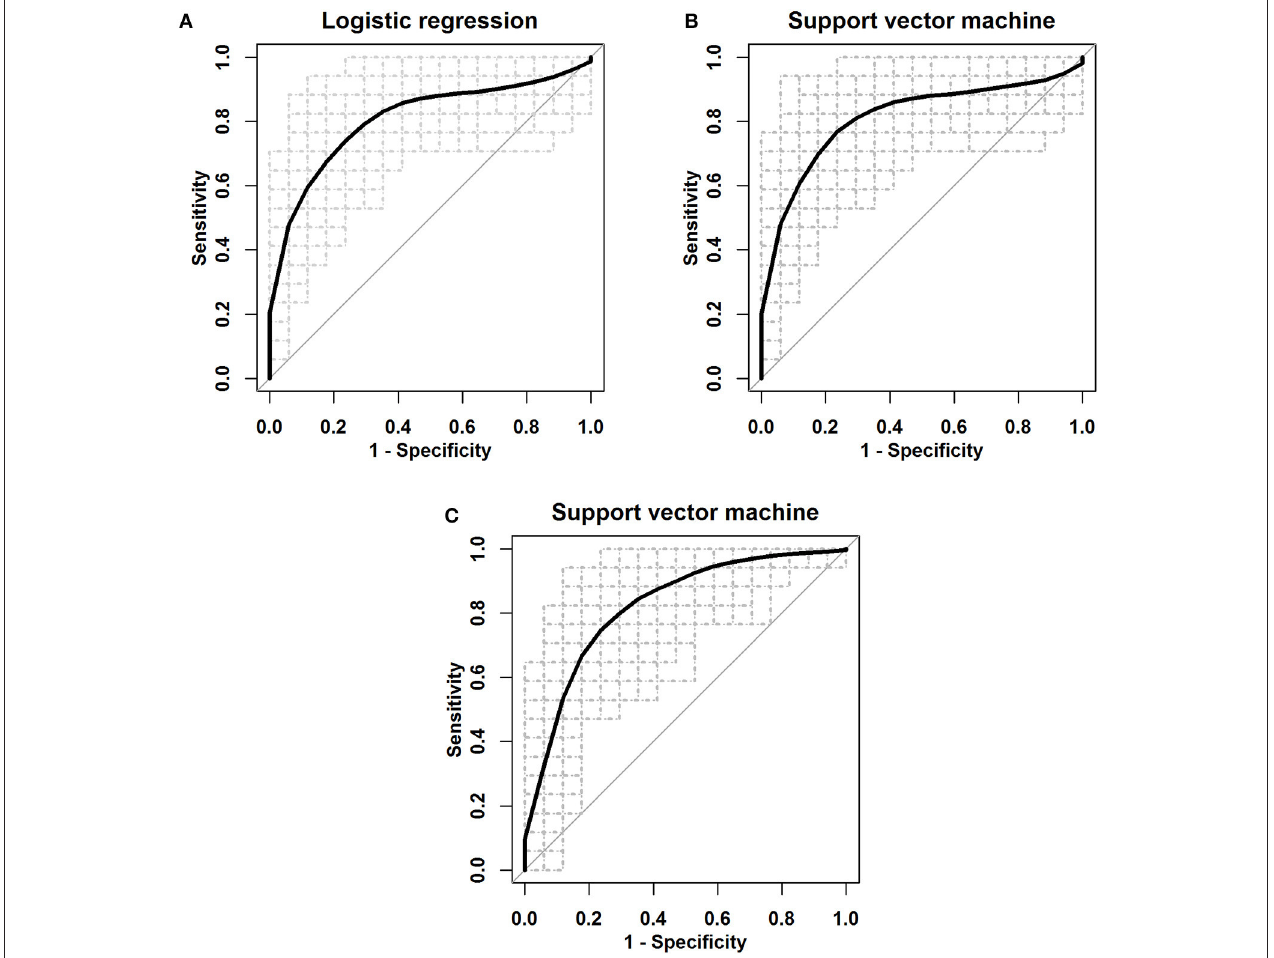
FIGURE 4 | The ROC curves for the three serum miRNA-based panel as a diagnostic biomarker by using three classifiers. (A) Logistic regression. (B) Linear SVM. (C) SVM with the Radial Basis Function kernel.